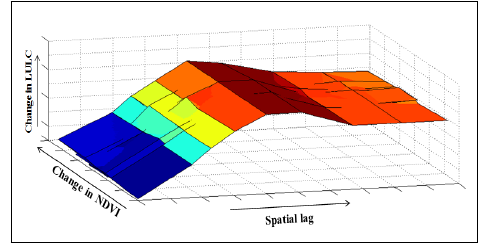
Figure 4. Spatio-semantic semivariogram with respect to LST Figure 5. Spatio-semantic semivariogram with respect to NDVI